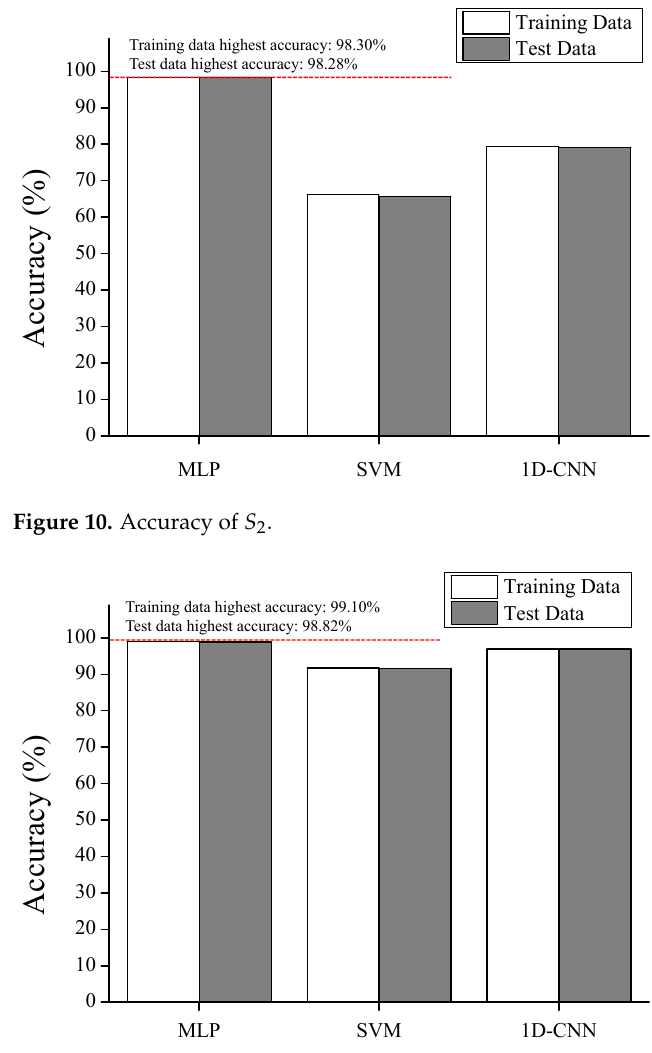
Figure 11. Total accuracy of all